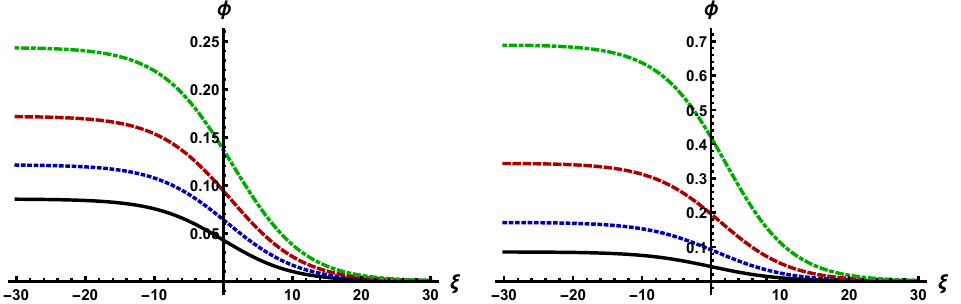
Figure 2. Time evolution of ( left panel ) cylindrical ( ν = 1) and ( right panel ) spherical ( ν = 2) NA shock waves in the CDENPs under consideration for U 0 = 0.1, η = 1, τ = − 20 (solid line), − 10 (dotted line), − 5.0 (dashed line), and − 2.5 (dashed-dotted line). See text for